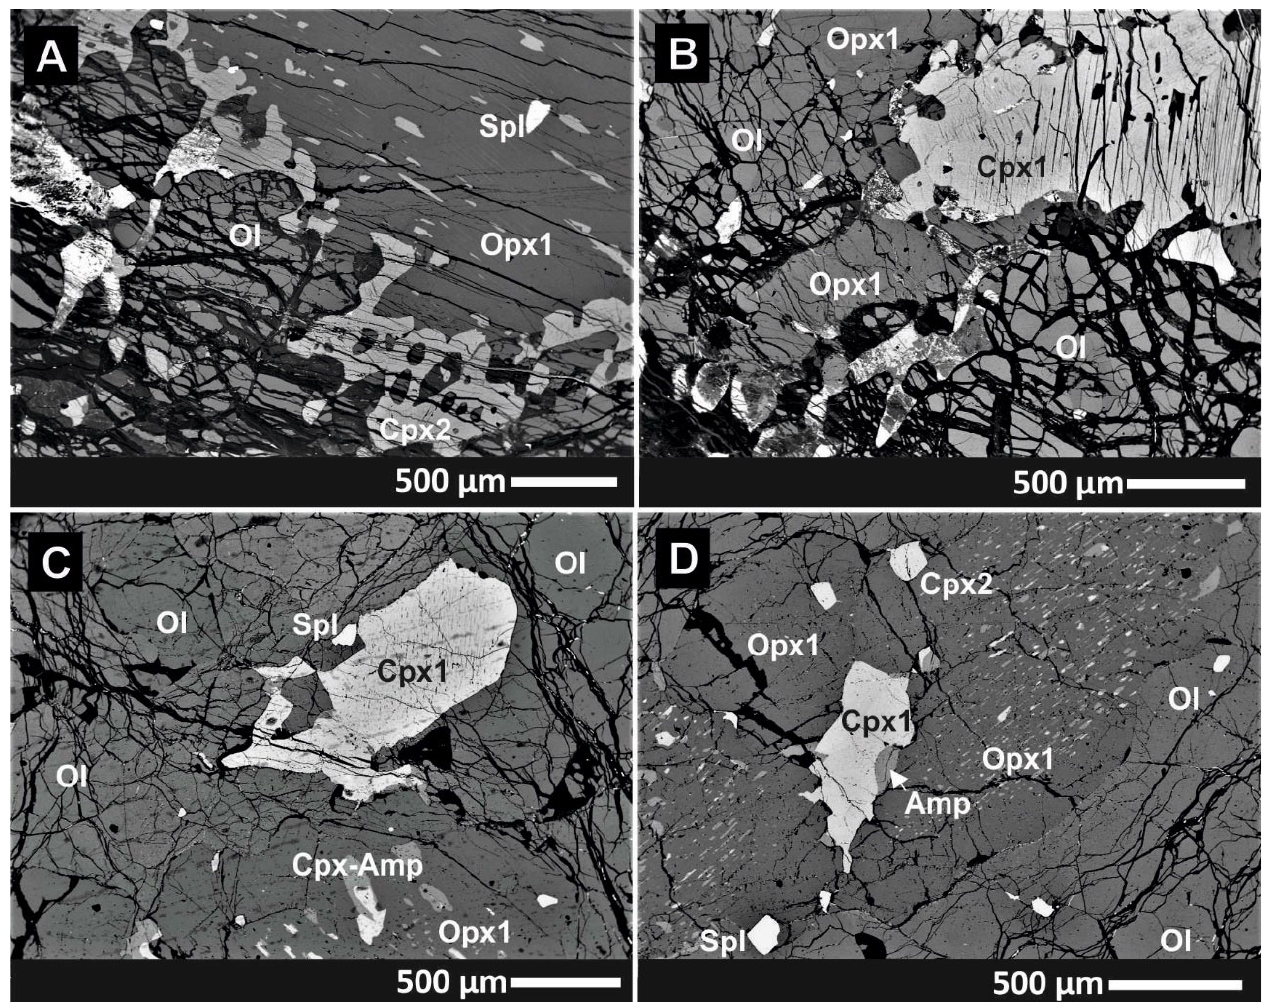
Figure 7. BSE images of harzburgites document magmatic to subsolidus stage mineral generations. ( A,B ) Partly dissolved Opx1 and Cpx1 porphyroclasts occur in the Ol matrix. Opx1 contains Cpx exsolutions, and Cpx1 shows Opx and Cr ‐ Spl exsolutions. Cpx2 follows Px1 boundaries and is partly extending into the Ol matrix (P29A2). ( C,D ) Opx1 contains Cpx exsolutions partly replaced by Amp ‐ Mhb. Cpx2 and Spl2 anhedral grains in boundaries of Px1 and the Ol matrix (P21).